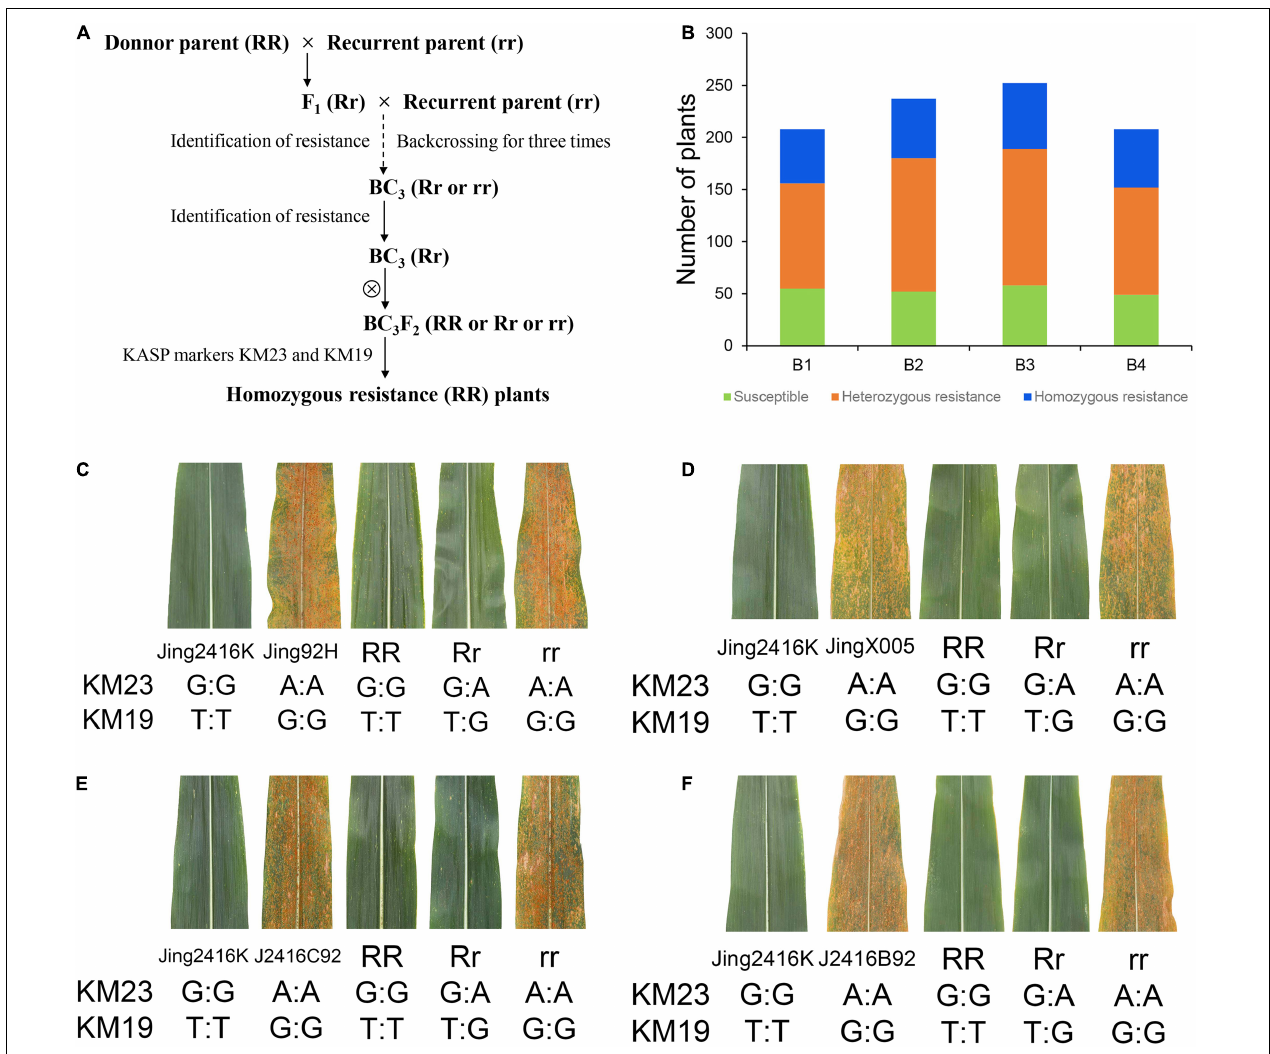
FIGURE 6 | Application of KM23 and KM19 in marker-assisted selection. (A) Overview of the procedure used to generate homozygous lines resistant to SCR. (B) Number of plants of each genotype in the four BC 3 F 2 populations B1, B2, B3, and B4 derived from crosses of Jing2416K with Jing92H, JingX005, Jing2416C92, and Jing2416B92, respectively. (C–F) Phenotypes and genotypes of BC 3 F 2 individuals. RR, Rr, and rr respectively indicate homozygous resistant, heterozygous resistant, and susceptible plants in the four BC 3 F 2